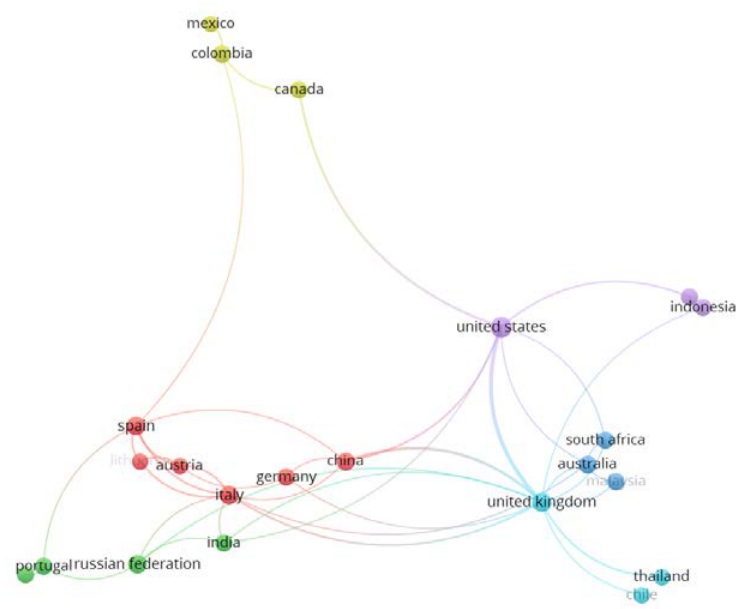
Figure 16. Networks of collaborations by